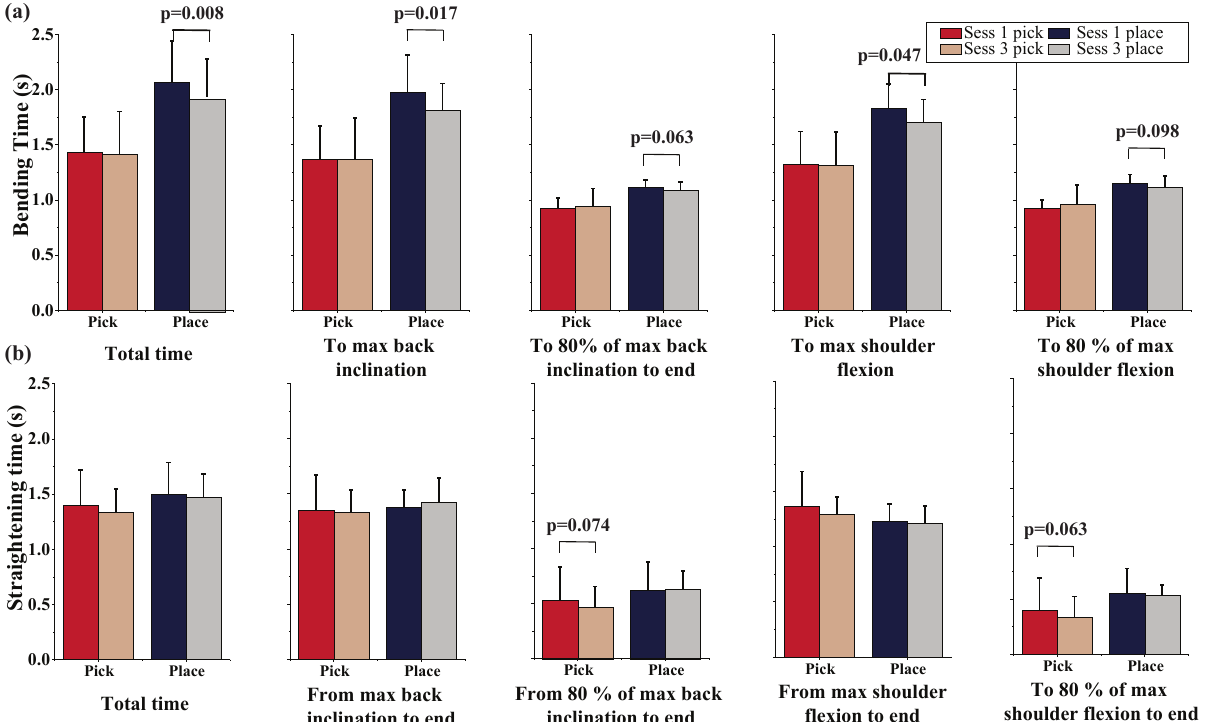
Figure 5. ( a ) Timings for the bending and ( b ) timings for the straightening between the first and last sessions. The bending during pickings and placings are compared